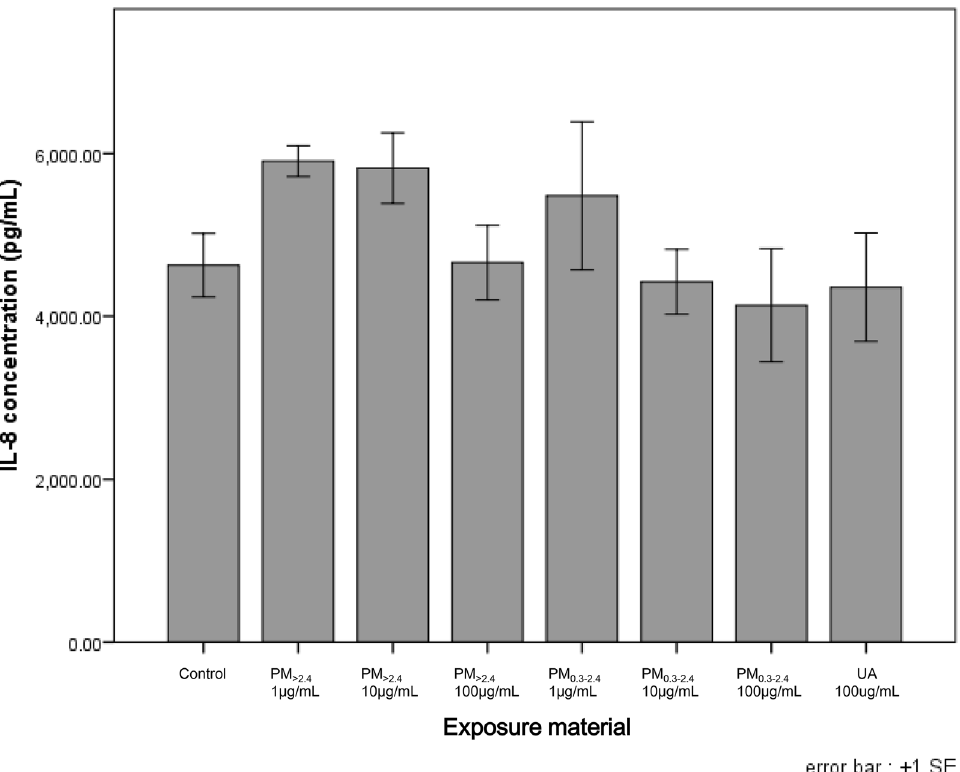
Figure 4. Production of IL-8 from reconstructed human corneal epithelial tissues following exposure to ambient particles and urban aerosols. Data are mean ± SE of 6 PM >2.4 , 3 PM 0.3–2.4 , 6 UA and 6 control individual cultures. This figure was created using the software SPSS Statistics 24.0 (https ://www.ibm.com/produ cts/spss- stati stics ?lnk=STW_US_STESC H_P1_BLK&lnk2=trial _SPSSs tat&lot=1&pexp=def&psrc=none&mhsrc =ibmse arch_a&mhq=spss). IL interleukin, SE standard error of the mean, PM > 2.4 particle matter larger than 2.4 µm, PM